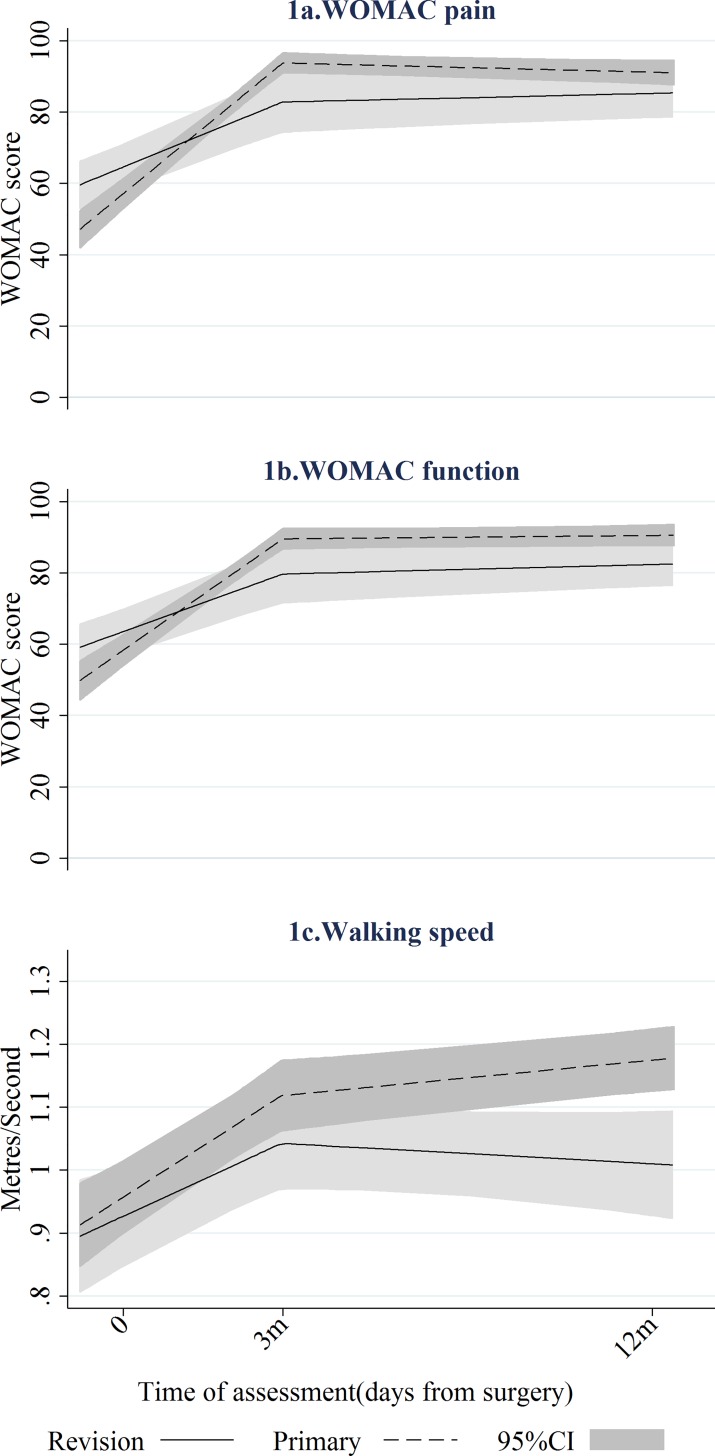
Mean trajectoriesa for WOMAC-pain, WOMAC-function and walking speed (Unstandardised outcomes) by revision/primary surgery.The mean trajectories are derived using the fixed effects terms of the linear mixed models stratified on primary-revision profile and regressing each outcome on the time of assessment parameterised as two linear splines.